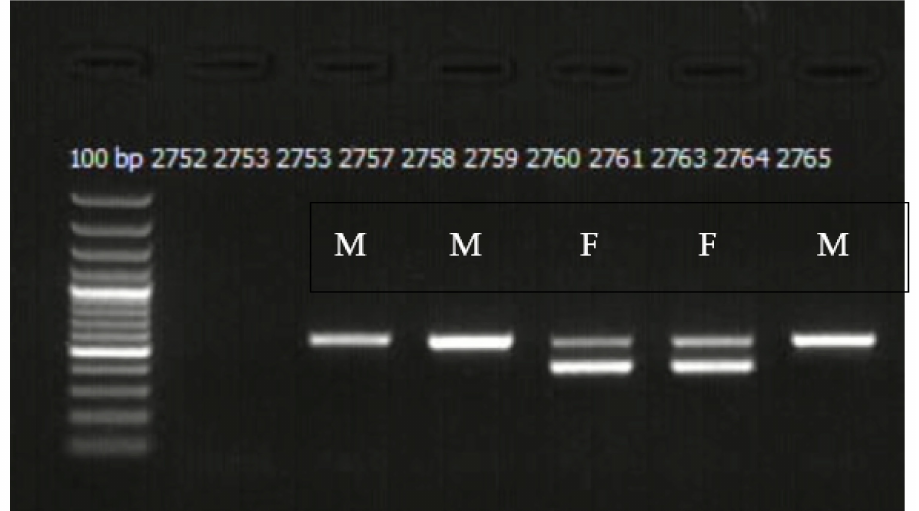
Figure 1. Molecular sexing results. One band is male, and two bands are